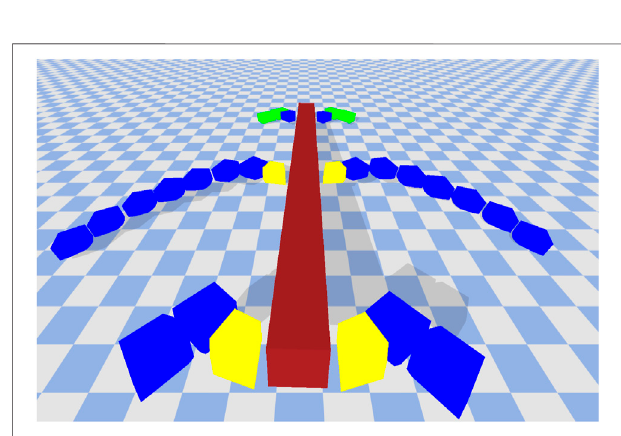
FIGURE9| Best performing solutiononthehigh friction surface.Covers 102.22 units in the x -direction. Normalized Friction (cid:2) 0.57, Normalized Restitution (cid:2) 0.57, Normalized Average Leg Size (cid:2)